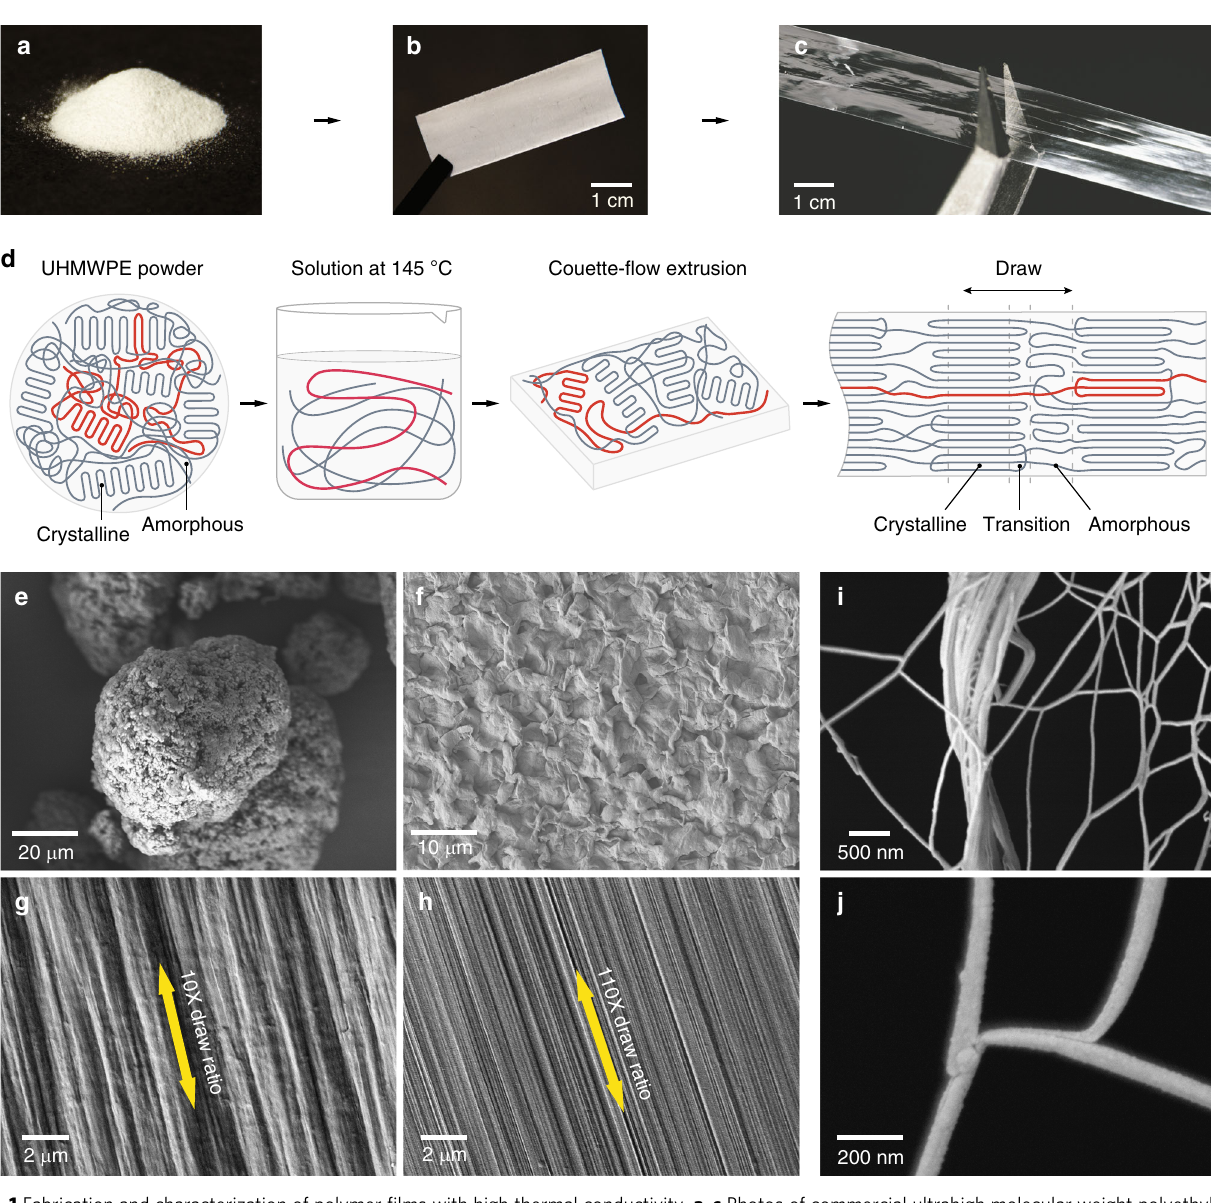
Fig. 1 Fabrication and characterization of polymer fi lms with high thermal conductivity. a – c Photos of commercial ultrahigh molecular weight polyethylene (UHMWPE) powders, a thick opaque as-extruded fi lm and a thin transparent drawn fi lm, respectively. d Illustration of fi lm morphology evolution during fabrication. The powders feature lamellar polyethylene crystallites embedded in a disordered and entangled chain network. The degree of entanglement greatly reduces in the hot decalin solution and after subsequent Couette- fl ow extrusion. The ultradrawn fi lms are characterized by oriented crystallites interconnected by aligned amorphous chains. e Scanning electron microscope (SEM) images of some UHMWPE powders. Scale bar indicates 20 μ m. f SEM image of an as-extruded fi lm. Scale bar indicates 10 μ m. g SEM image of a 10× draw ratio fi lm. Scale bar indicates 2 μ m. h SEM image of a ×110 fi lm. Scale bar indicates 2 μ m. i , j SEM images of a torn ×70 fi lm revealing the polyethylene nano fi bers as the basic building blocks. Scale bar indicates 500 nm and 200 nm,